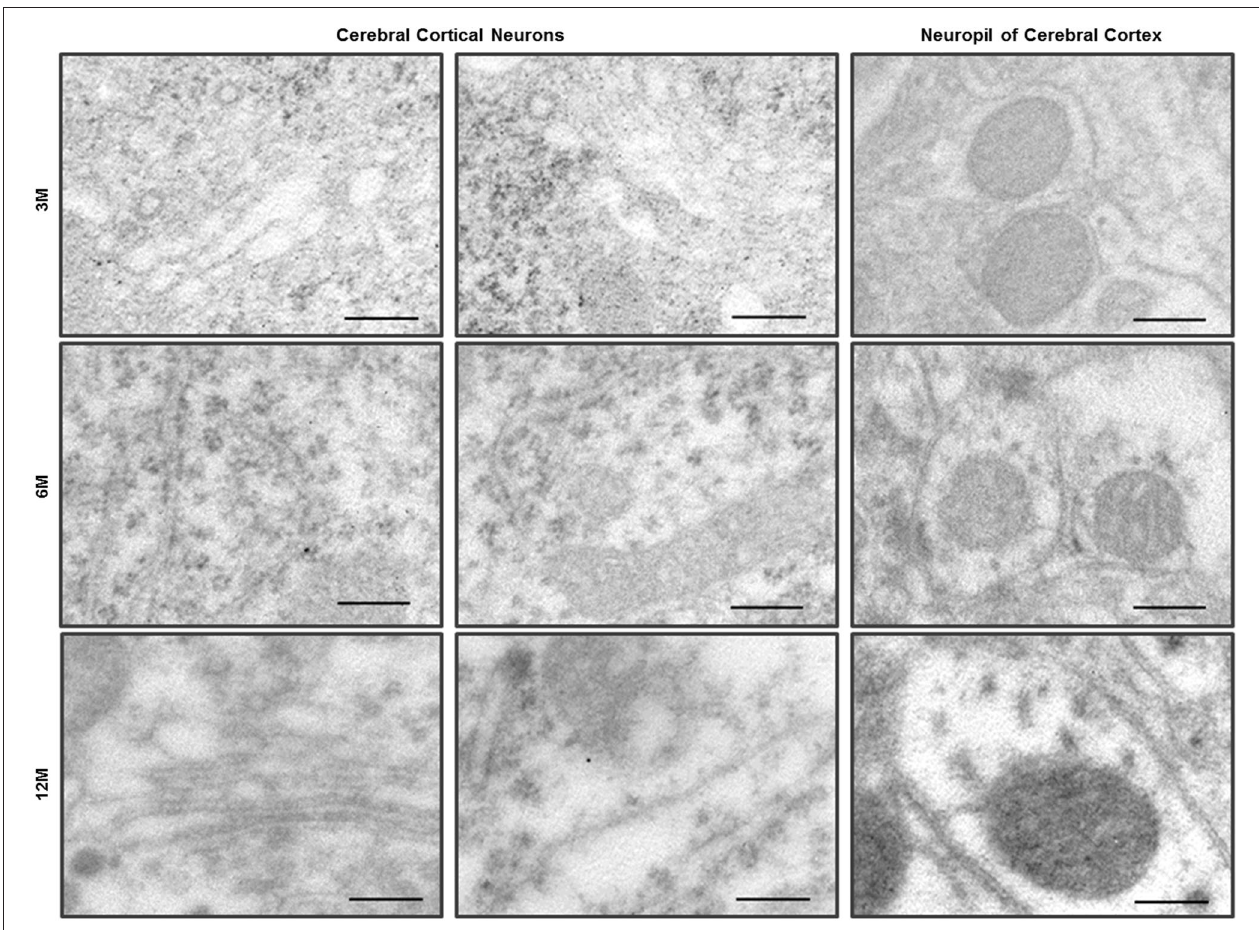
FIGURE 3 | Immuno-EM analysis with anti-LC3B antibody in the cerebral cortex of C57BL/6J mice . LC3 immunogold particles were not observed on the neurons and neurites in the neuropil of cerebral cortex. Scale bars, 200